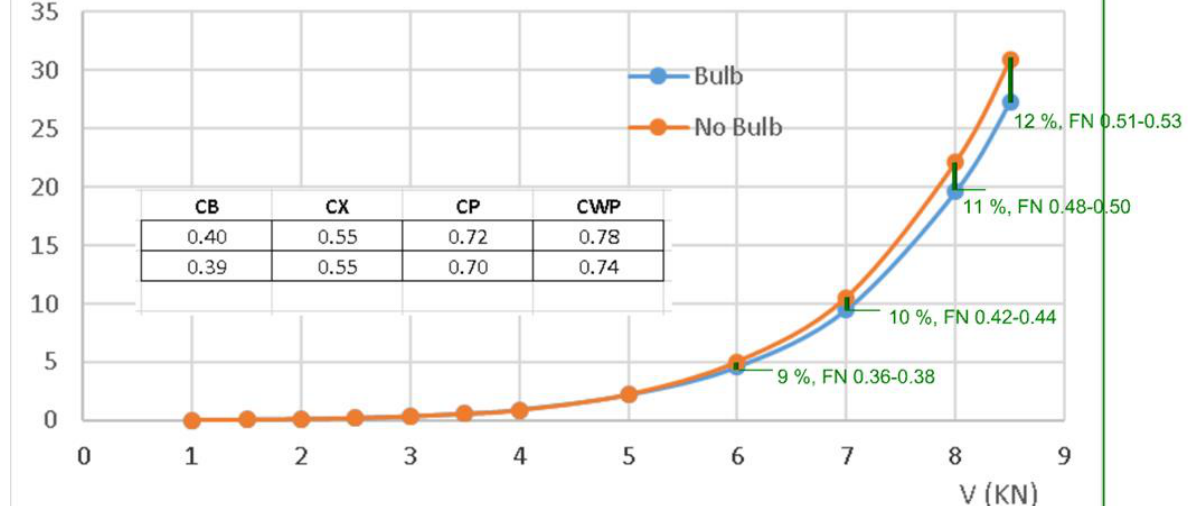
Figure 20. Power reduction for FAO3 vs. FAO4, heavy conditions.